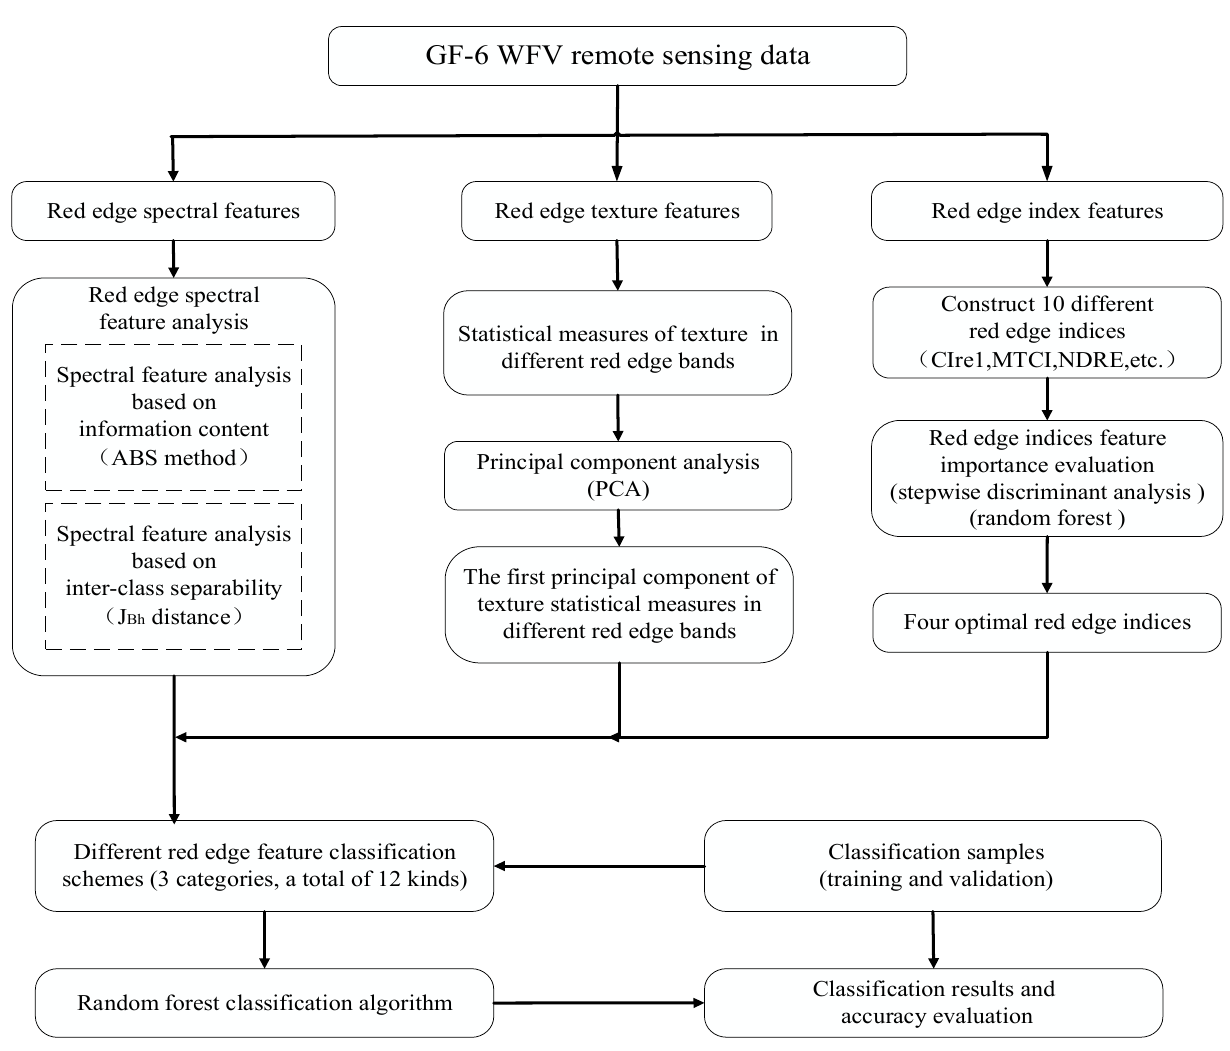
Figure 2. Technical route of the study.